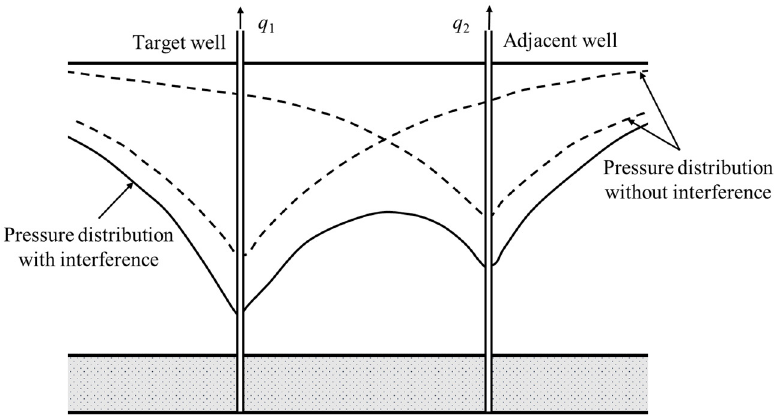
Figure 7. Schematic diagram of the pressure superposition principle between two wells.